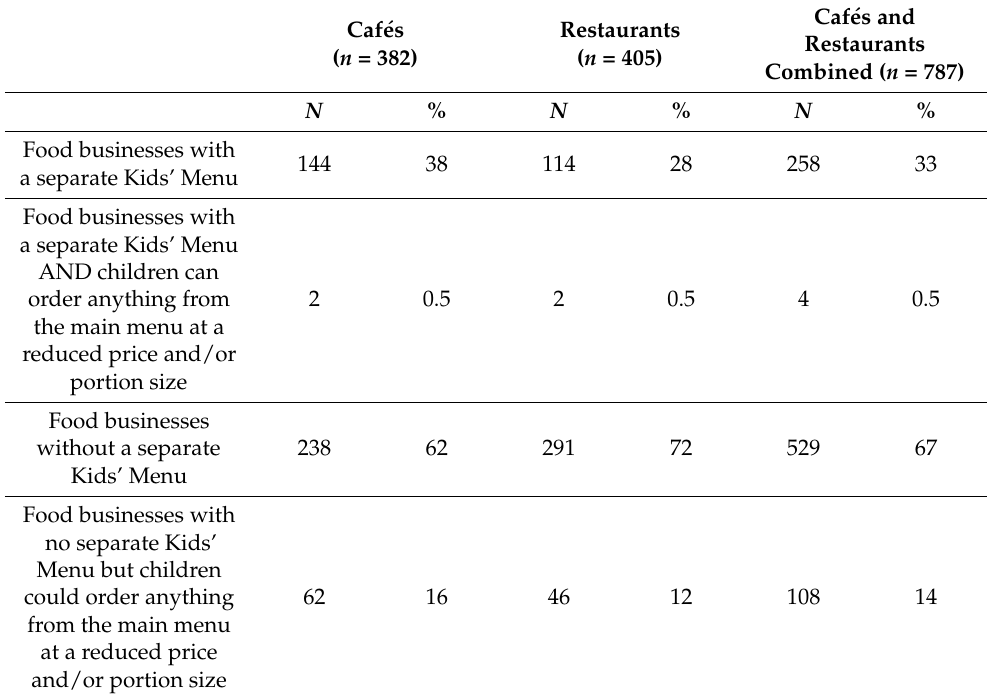
Table 1. Proportion of Kids’ Menus in caf é s and